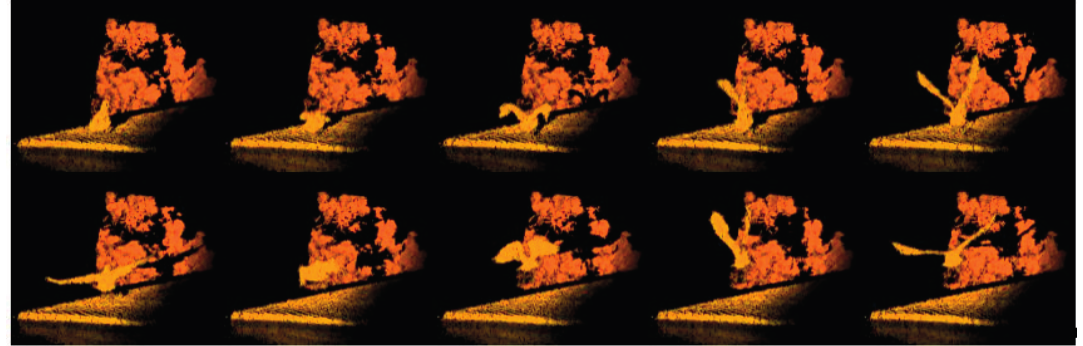
Figure 3. Propeller tips move at 220 meters per second without motion blur.